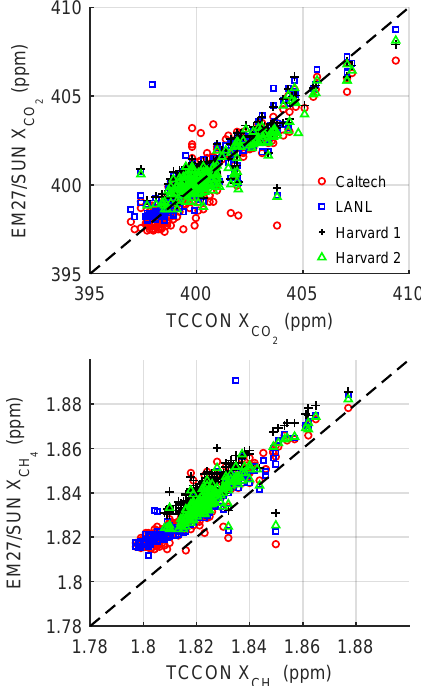
Figure 9. Retrieved EM27/SUN measurements (10min averaging) as compared to the TCCON from January 2015. This provides a visual representation of the data – offset and scatter of data between X gas from different instrument types – in Table 3. The black dashed line is the 1 : 1